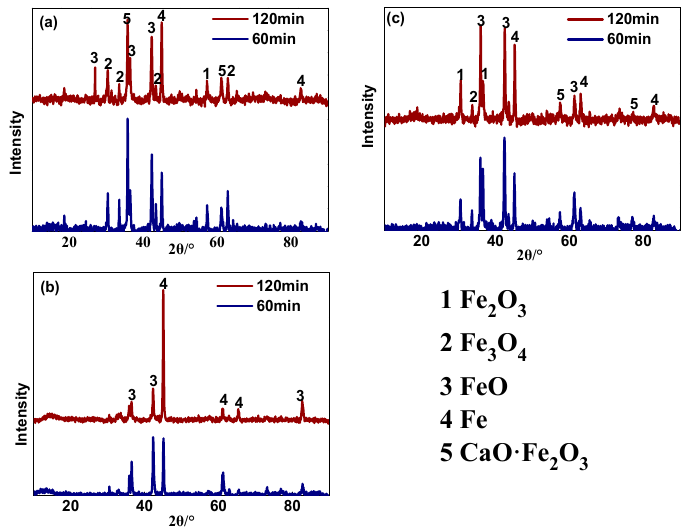
Figure 5. XRD patterns of sinter at different stages ( a ): 1.3 wt% MgO in 800 °C ( b ): 1.3 wt% MgO in ◦ C ( c ): 2.0 wt% MgO in 800 ◦ C. 900 °C ( c ): 2.0 wt% MgO in 800 °C. 900